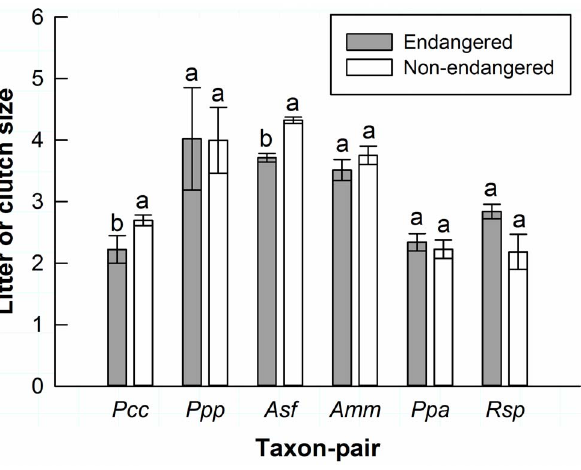
Figure 3. Reproduction within taxon-pairs. Mean litter or clutch size ( 6 SE) for taxon-pairs with a minimum of three